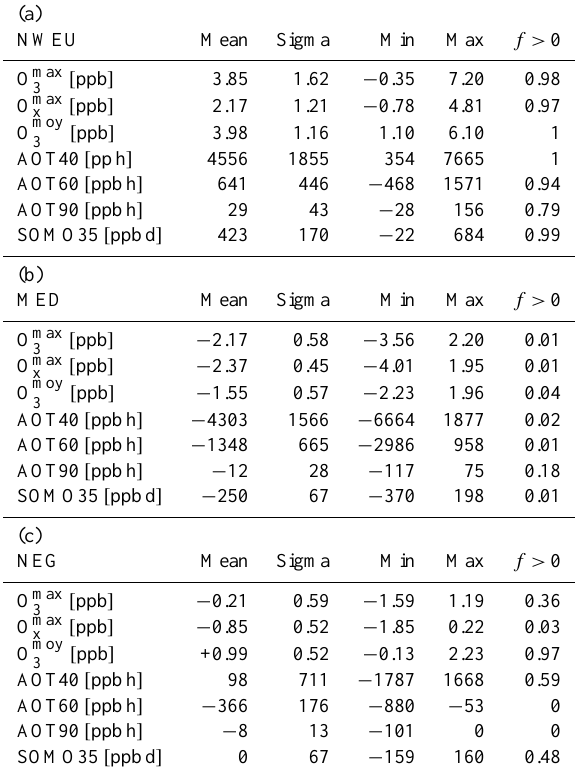
Table 1. Statistical measures for the average chemical regime statistics for summers 2001–2003; sigma, min and max denote the spatial variability of temporal averages, f > 0 the fraction of grid cells with average VOC sensitive chemical regime; for three